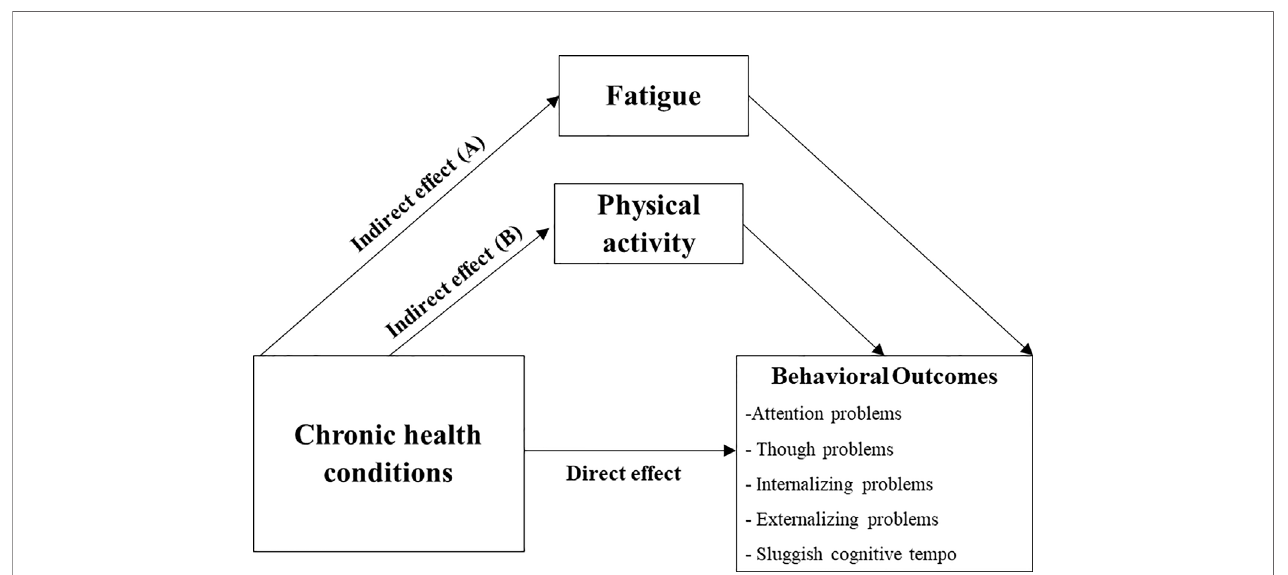
FIGURE 3 | Predicted Mediation Pathway (Exploratory Analysis). Predicted mediation pathway for association between chronic health conditions and behavioral outcomes, via fatigue (A) and physical activity (B) . Mediation analysis was run separately for each behavioral measure, controlling for sex, age at evaluation, age at diagnosis and cranial